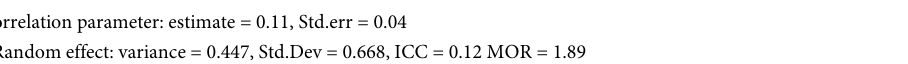
Infection with T . cruzi (positive)